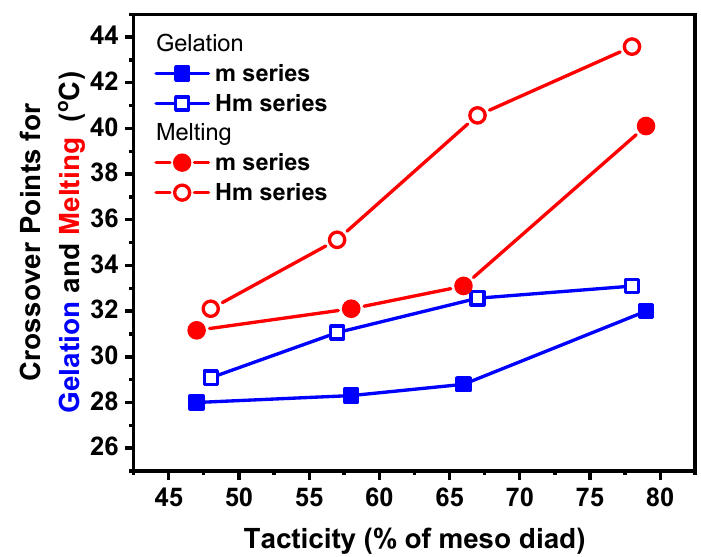
Figure 4. The crossover point for melting ( ● , ○ ) and gelation ( ■ , □ ) procedures vs the tacticity for m (solid symbol) and Hm (open symbol) series.